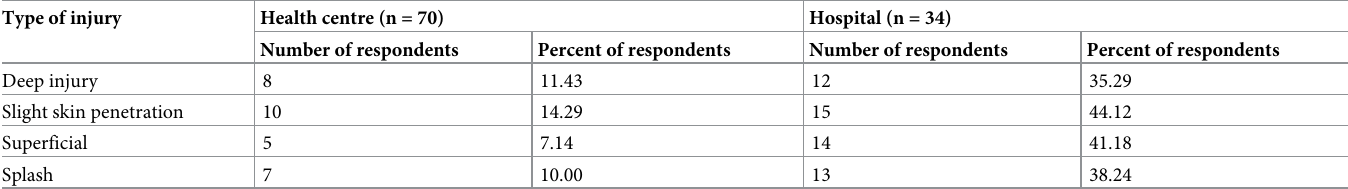
Table 13. Managers response to types of injury sustained in the study health facilities, Addis Ababa City Administration, February 2018.